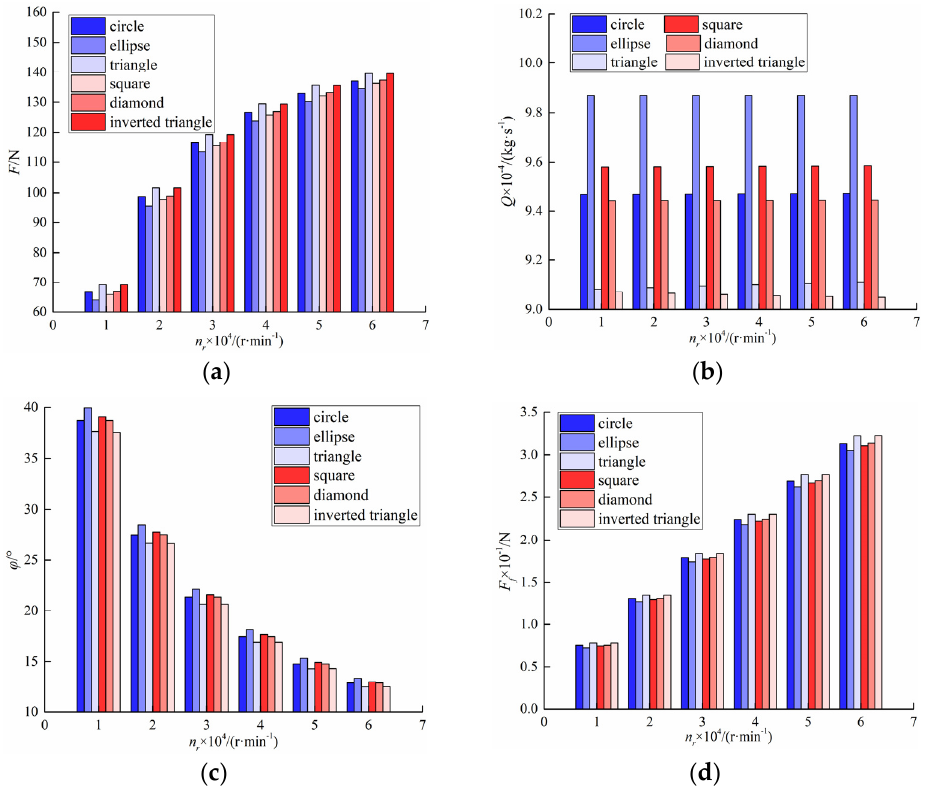
Figure 8. ( a ) Description of force with rotational speed. ( b ) Description of leakage with rotational speed. ( c ) Description of attitude angle with rotational speed. ( d ) Description of friction with rotational speed.